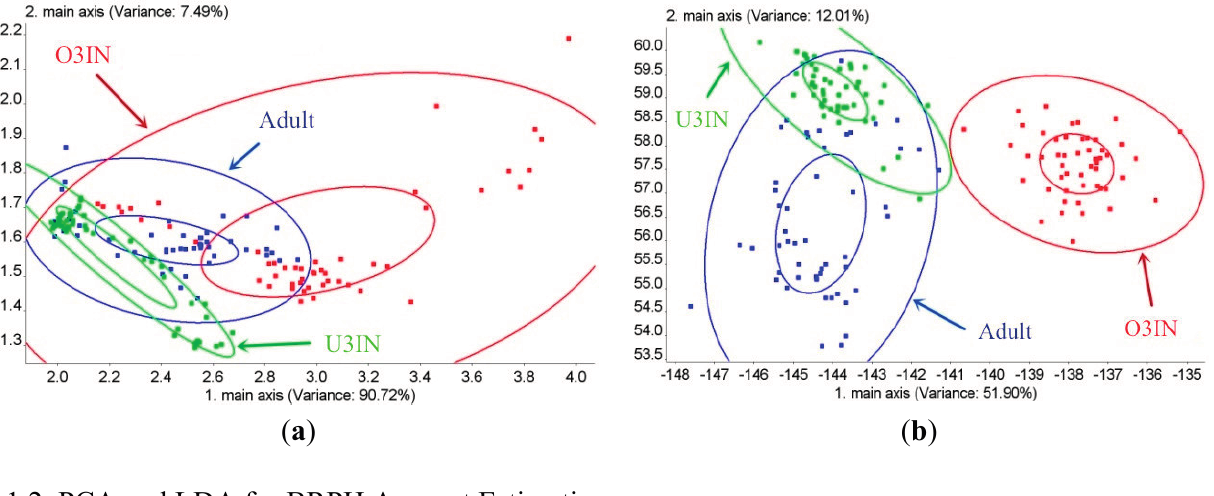
Figure 4. Age classification of BRPH: ( a ) PCA for age classification of BRPH; ( b ) LDA for age classification of